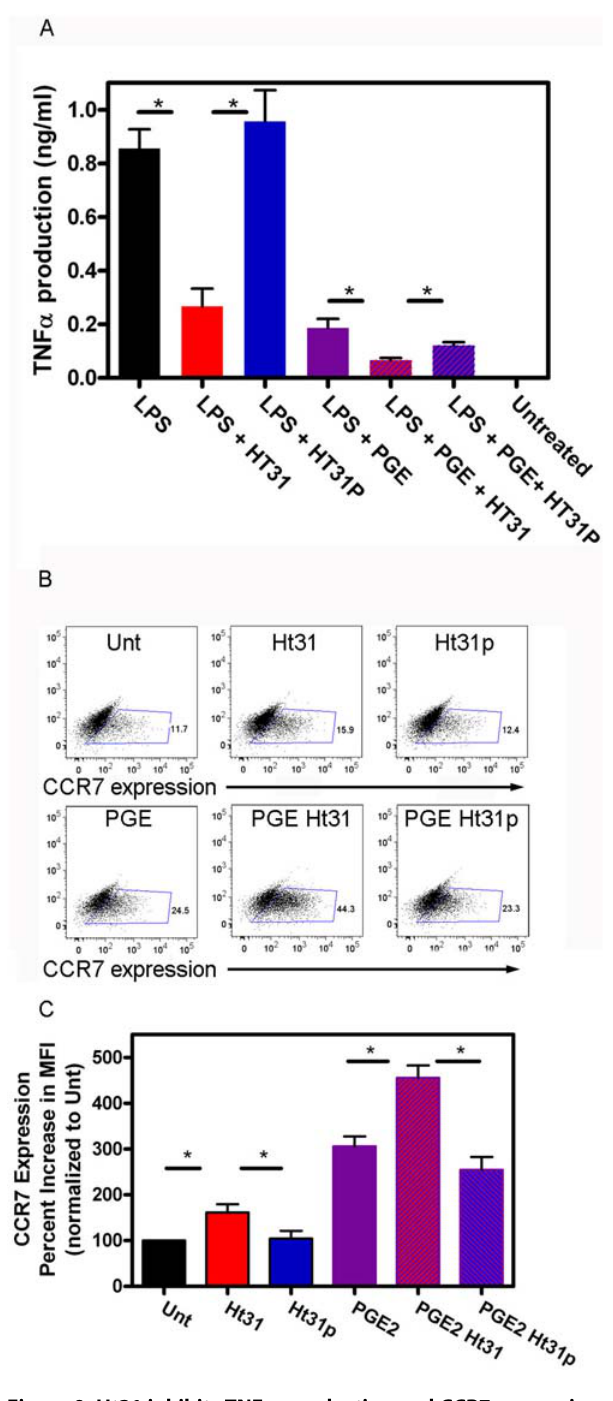
Figure 9. Ht31 inhibits TNF- a production and CCR7 expression. A) Day 5 DC were incubated with 10 ng/ml LPS without (Unt, black bars) or with 100 m M Ht31 (red bars) or Ht31p (blue bars) and 1 m M PGE 2 without (purple bars) or with 100 m M Ht31 (purple and red hatched bars) or Ht31p (purple and blue hatched bars) for 24 hours at 37 u C, 5% CO 2 . Supernatants were collected and used in TNF- a ELISA (Ebioscience). Three experiments were averaged. Error bars are S.E.M. Student TTEST reveals significance, P , 0.05(*). B, C) Day 5 DC were incubated without (Unt, black bars) or with 100 m M Ht31 (red bars) or Ht31p (blue bars) and 1 m M PGE 2 without (purple bars) or with 100 m M Ht31 (purple and red hatched bars) or Ht31p (purple and blue hatched bars) for 48 hours at 37 u C, 5% CO 2 . Cells were collected, blocked, and stained for cell surface expression with anti-CCR7. FACS analysis